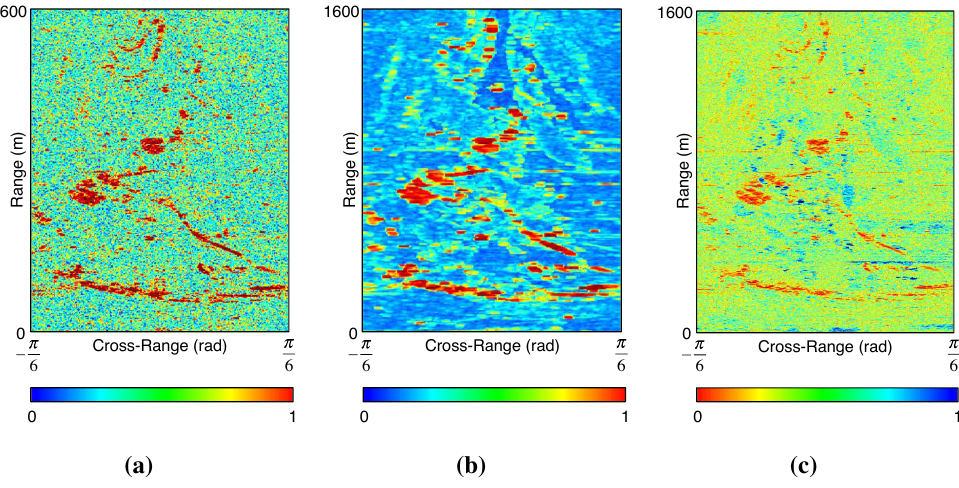
Figure 7. ( a ) TSC; ( b ) mean coherence; and ( c ) D for the GB-SAR